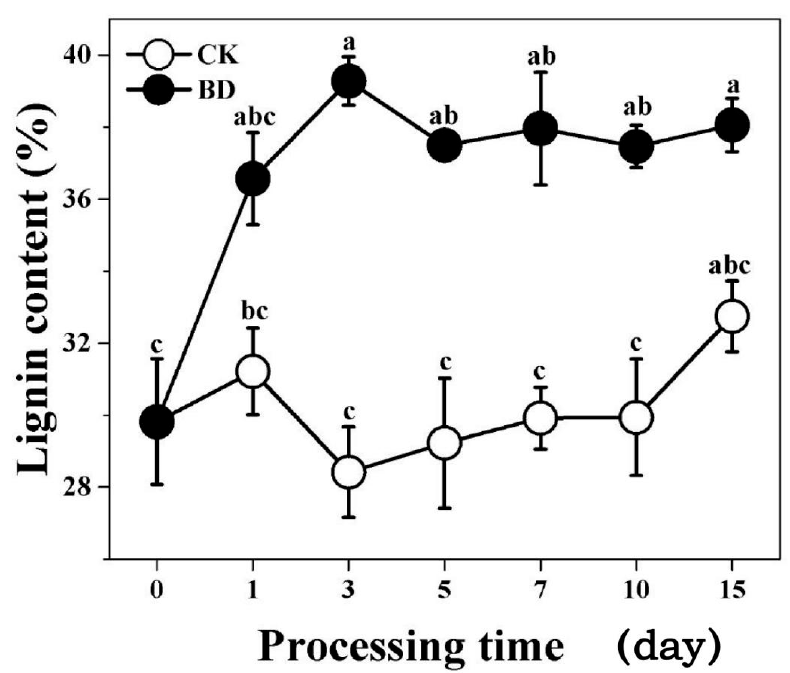
Figure 1. Lignin content in the “Nanlin895” roots in different treatment periods. The hollow circle and solid circle lines represent the boron deficiency (BD) and control (CK) treatments, respectively. Data are expressed as the mean ± SE ( n = 3). a,b,c Different letters above the error bars indicate significant differences at the 0.05 level.